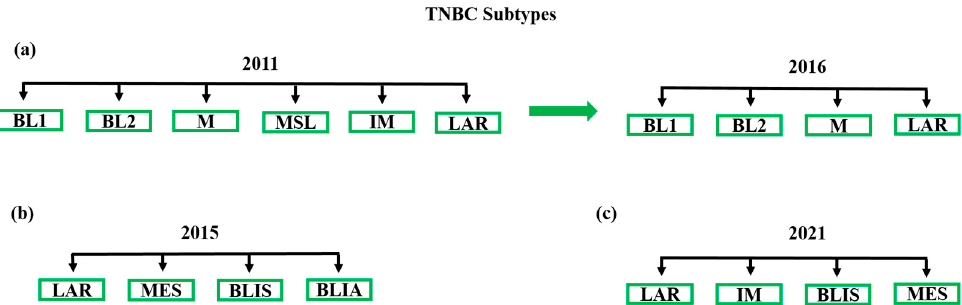
Figure 1. Major TNBC subtypes based on gene expression profiles. ( a ) Lehmann et al. classified TNBC patients into six subtypes (TNBCtype) in 2011: basal-like 1 (BL1), basal-like 2 (BL2), mesenchymal (M), mesenchymal stem-like (MSL), immunomodulatory (IM), and luminal androgen receptor (LAR) [52]. In 2016, Lehman et al. re-classified the TNBC molecular subtypes from six (TNBCtype) to four (TNBCtype-4) tumor-specific subtypes: BL1, BL2, M, and LAR [56]. ( b ) Burstein el al. suggested four subtypes: luminal androgen receptor (LAR), mesenchymal (MES), basal-like immunosuppressed (BLIS), and basal-like immune-activated (BLIA) [54]. ( c ) FUTURE trial schema: LAR, immunomodulatory (IM), mesenchymal-like (MES), and basal-like immune-suppressed (BLIS)